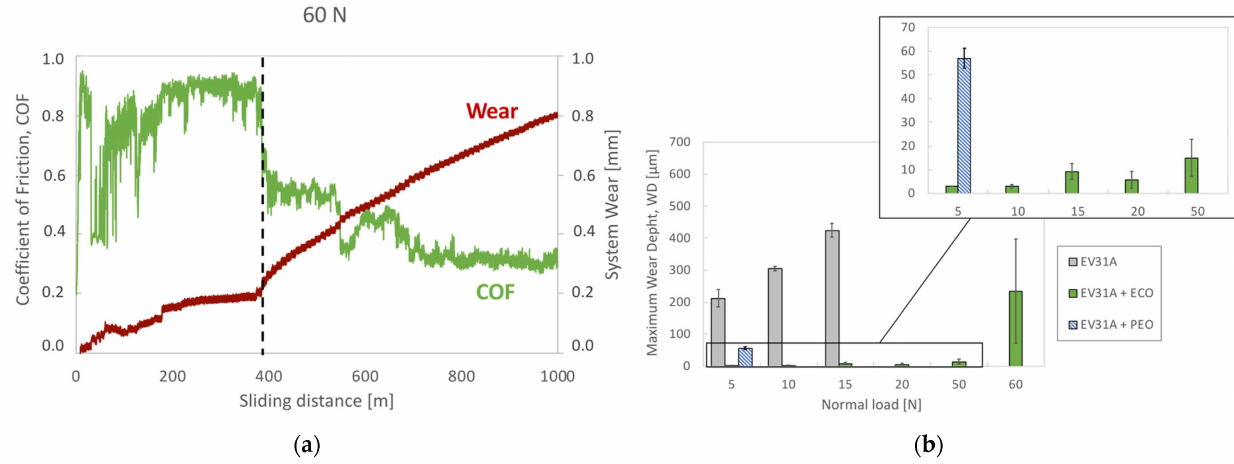
Figure 9. Dry sliding tests (vs. 100Cr6 steel, 1000 m, 0.3 m/s): dynamic coefficient of friction vs. system wear as a function of sliding distance for ECO-treated EV31A at 60 N, showing a transition in the friction and wear behavior (due to involvement of the substrate in the contact, i.e., end of coating life) at about 400 m ( a ); maximum wear scar depth of sliders measured after dry sliding tests: the inset highlights data for ECO and PEO layers up to 50 N (data for PEO-treated EV31A from [28]) ( b ).